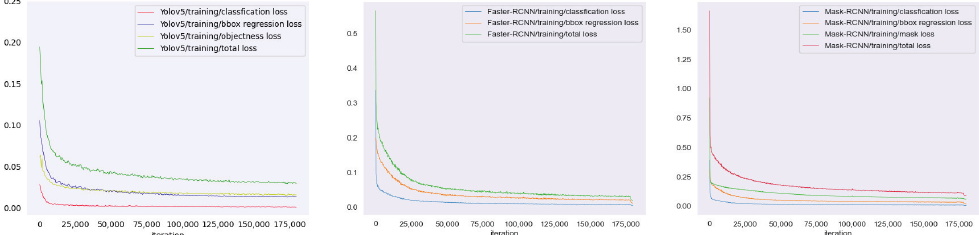
Figure 13. The loss tendency of Yolov5, Faster-RCNN and Mask-RCNN models for insect pest detection in training.